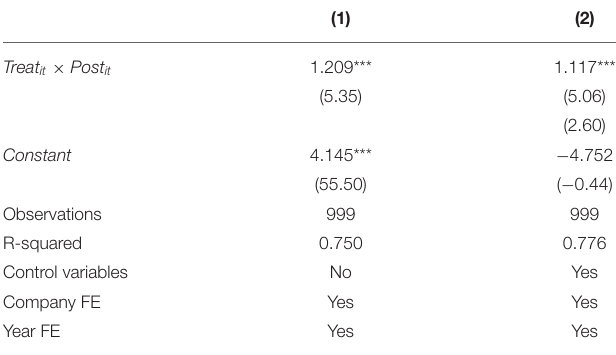
TABLE 3 | Benchmark regression